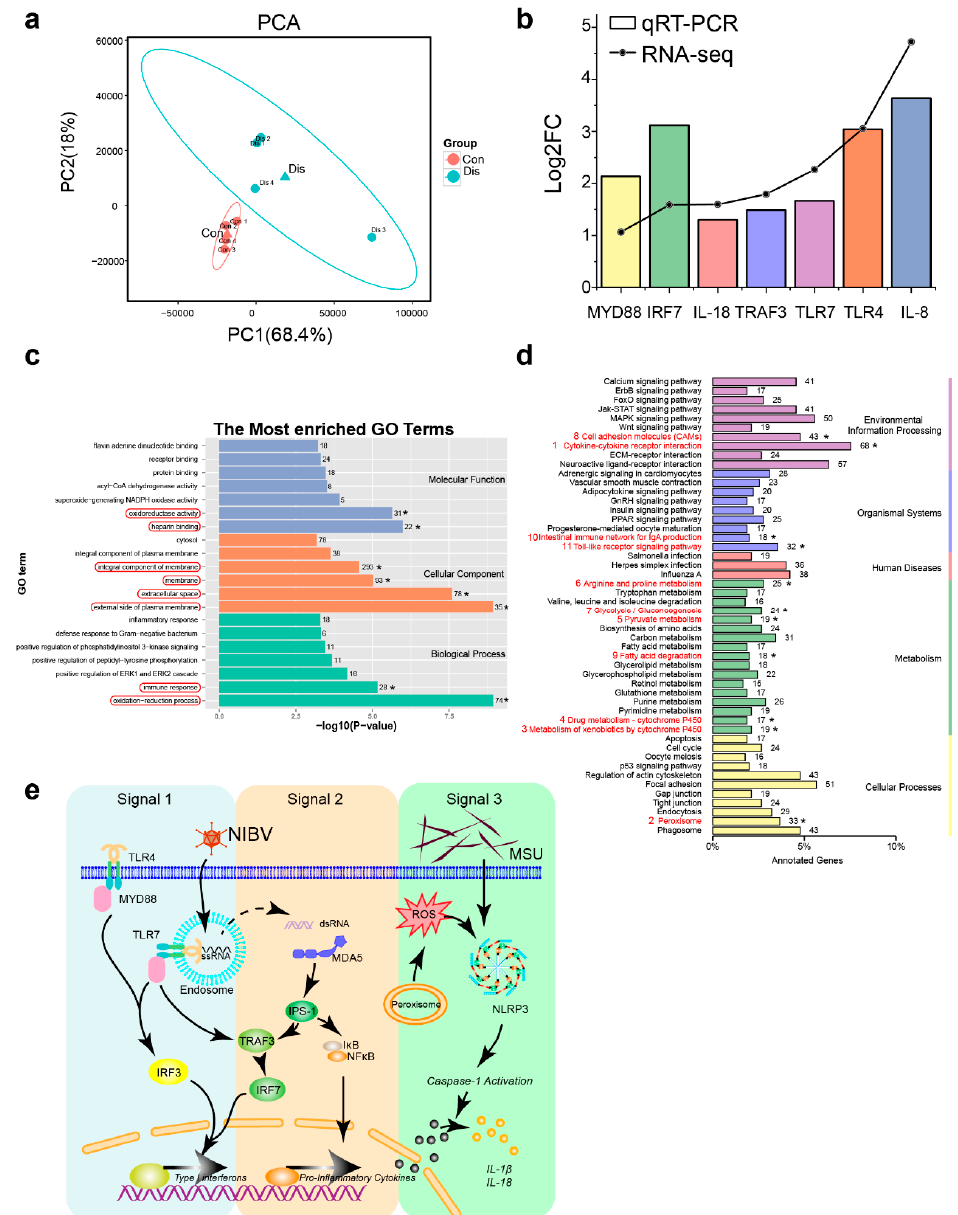
Figure 3. Transcriptome analysis of chickens with NIBV infection. ( a ) PCA plot showing the distinction between Dis and Con group based on gene expression. The blue and red triangles represent the mean coordinates (center point) of the Dis and Con group, respectively. ( b ) RT-qPCR validation of differentially expressed genes. ( c ) Gene ontology (GO) enrichment analysis of Differential expression genes (DEGs) between Con group and Dis group shows the 20 most enriched GO terms * represents the significantly changed GO terms with p adj < 0.05 and the red bar is for highlighting. ( d ) Kyoto Encyclopedia of Genes and Genomes (KEGG) pathway classification enrichment analysis of DEGs. The y-axis and x-axis indicate the KEGG pathway and the percentage of annotated genes, respectively. The 11 significantly enriched pathways are listed with red serial number. ( e ) The schematic diagram representing important processes in chickens affected by NIBV infection, which activate innate immunity to antiviral infection. (Signal 1) Toll-like receptor (TLR) signalling is activated by the nucleic acid. TLR7 which is located in endosomal membrane induces production of type I interferon and proinflammatory cytokines via MyD88-NF- κ B / IRF signalling pathway. (Signal 2) RIG-I-like receptor signaling is activated by dsRNA intermediates produced during NIBV replication. MDA5 recognizes a complementary set of cytosolic viral dsRNA ligands which can also activate NF- κ B signalling. (Signal 3) NOD-like receptor